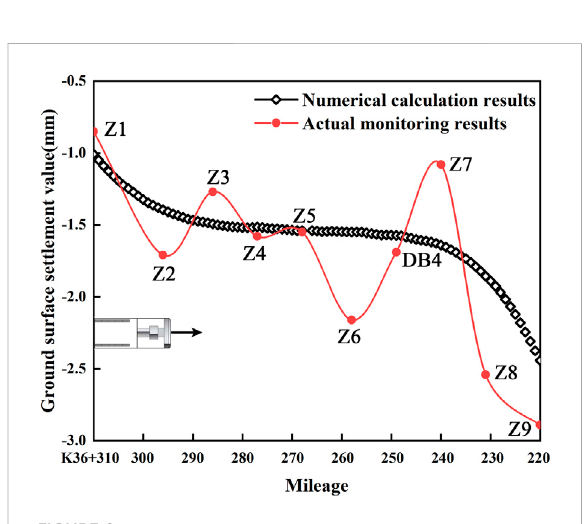
FIGURE 9 Axialgroundsurfacesettlement intheleftlineofthetunnel in the underpass area.